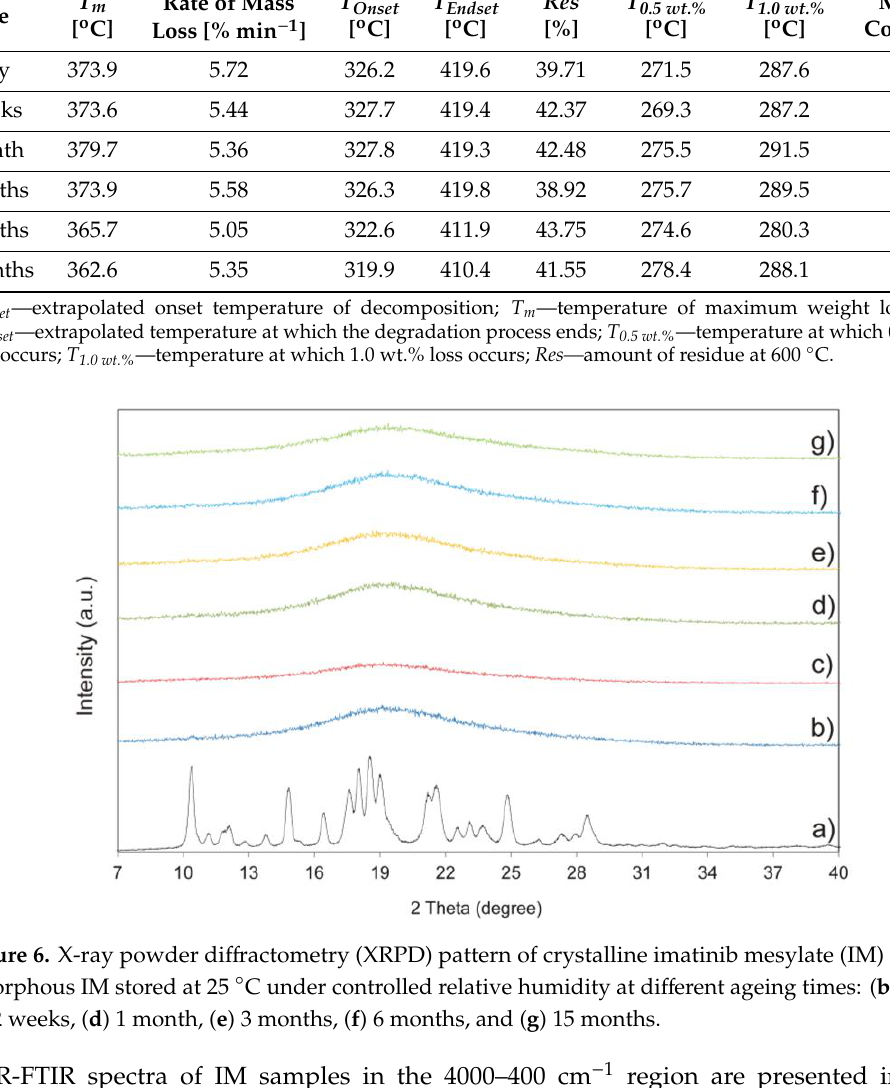
Figure 7. Attenuated total reflectance-Fourier transform infrared spectroscopy (ATR-FTIR) spectra crystalline imatinib mesylate (IM) ( a ) and amorphous IM stored at 25 °C under controlled relative humidity at different ageing times: ( b ) day 0, ( c ) 2 weeks, ( d ) 1 month, ( e ) 3 months, ( f ) 6 months, and ( g ) 15 months. In order to estimate the morphology of IM samples, scanning electron microscopy (SEM) analysis was performed. SEM images of crystalline and amorphous IM are shown in Figure 8.